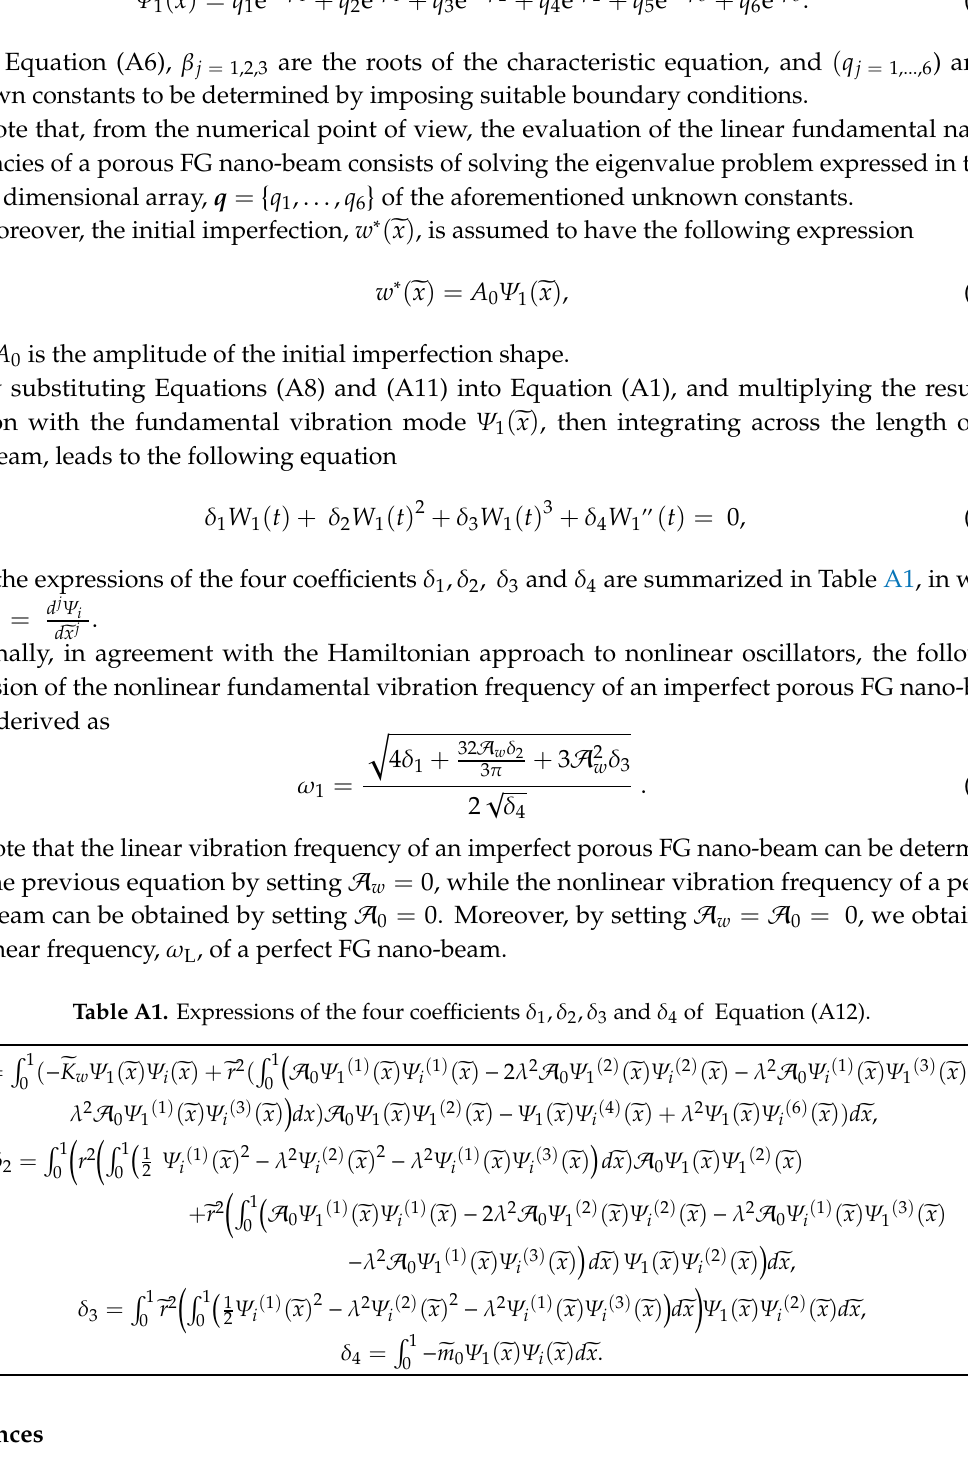
( 2 ) ( (cid:101) x ) Ψ Ψ 0 1